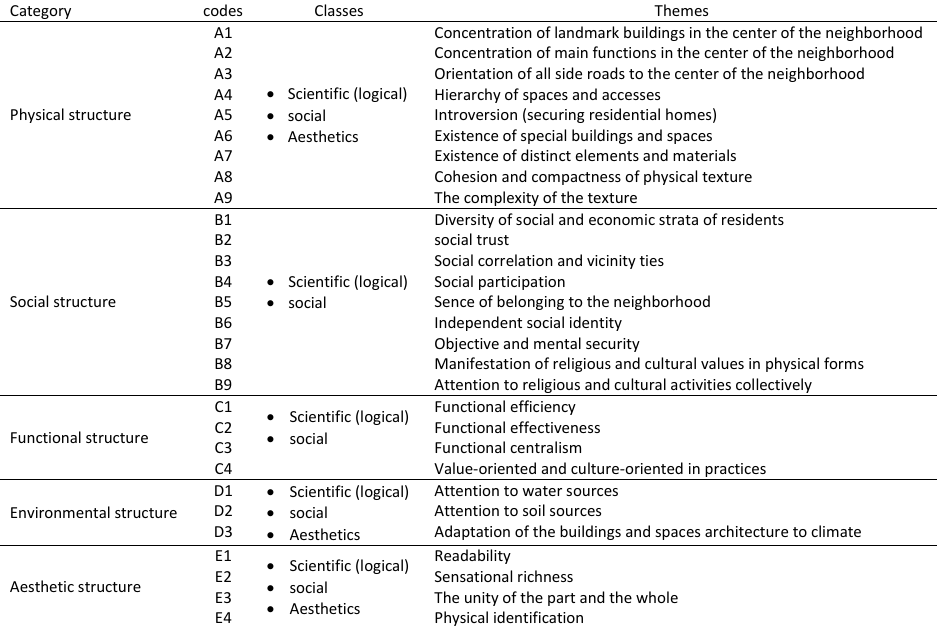
Table 2: The Second level open coding at three levels: scientific, social and aesthetic